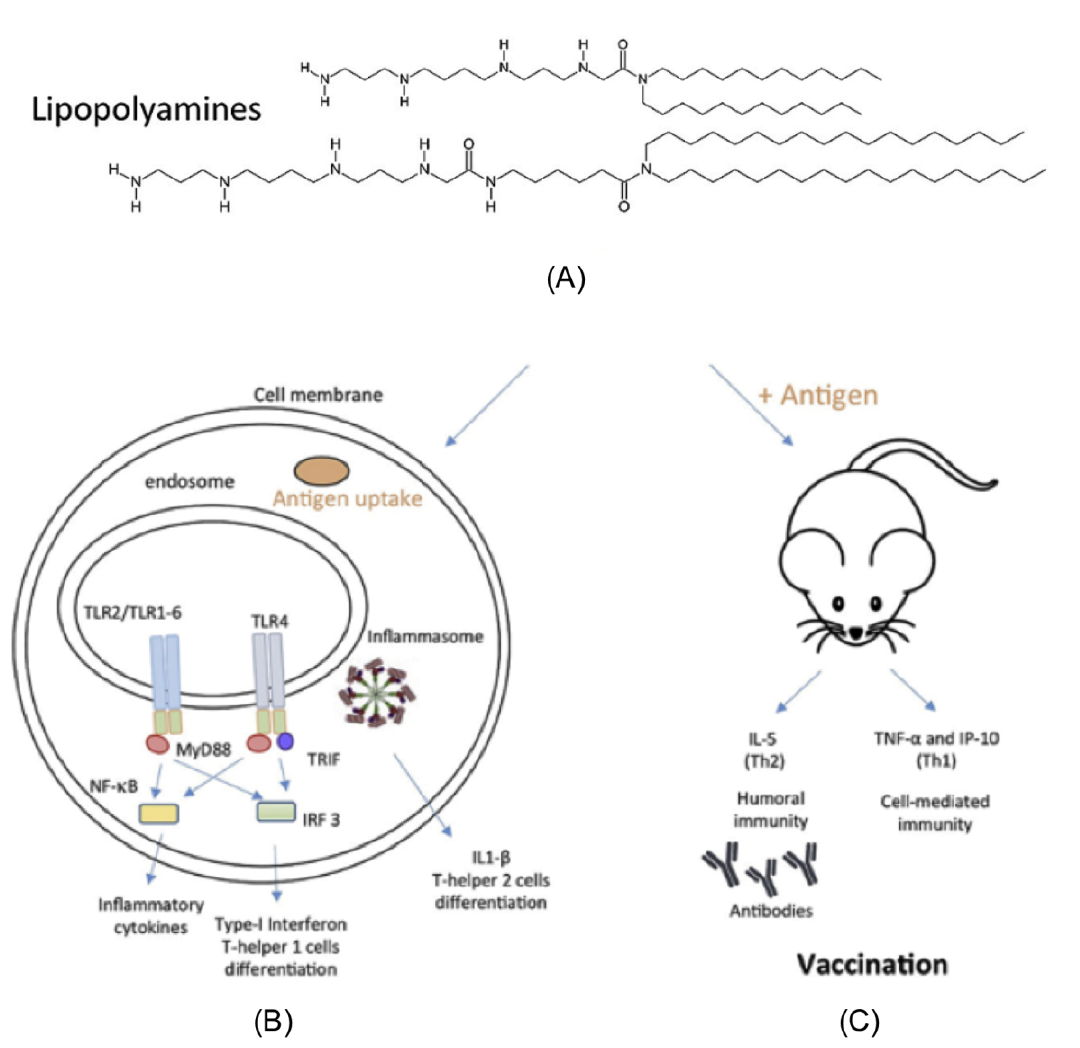
Figure 3. ( A ) Chemical structure of lipopolyamines (12 or 18 C). ( B ) Uptake of lipopolyamines alone or complexed with ovalbumin by cultured human cell lines transfected with Toll-like Receptors (TLRs), leading to 1) secretion of inflammatory and type-I interferon cytokines able to trigger a Th1 response (cell-mediated immunity); 2) secretion of the interleukin-1beta (IL-1β) able to induce a Th2 response (humoral immune response). ( C ) Uptake of lipopolyamines/antigen complexes in vivo by intraperitoneal macrophages induced secretion of interleukin-5 (IL-5) and humoral immunity plus tumor necrosis factor-alpha (TNF-α) and gamma-interferon inducible protein (IP-10) [71], typical inducers of Th1 response (cell-mediated immune response) by the cultured macrophages. Reprinted from [70] with permission from Elsevier, Copyright 2018.